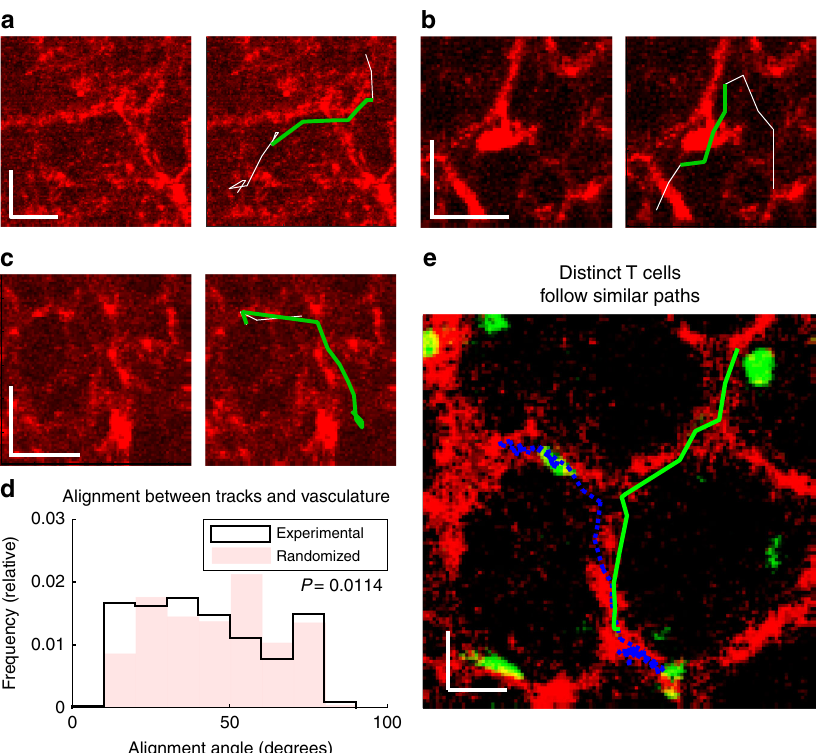
Fig. 5 Guidance of lung-in fi ltrating T cells along the vasculature. GFP + effector T cells were injected i.v. into LPS-treated mice. After two to fi ve days, the vasculature was labeled intravitally by intravenous injection of fl uorescently labeled lectin. Two-photon imaging of explanted lungs enabled simultaneous visualization of GFP + T cells and the vasculature. a – c High-resolution images of vascular stain of live lung tissue ( left panels ) with superimposed T cell trajectories ( right panels ). Tracks that are apparently aligned with the vasculature are highlighted in green. Scale bars = 20 µ m. d Tracks were split into 24 µ m wide segments ( n = 414 segments from ten movies). For each experimental segment, a randomized control segment was generated. An alignment angle, between segments and the main orientation of the vasculature, was calculated for all experimental and randomized segments. The Mann – Whitney test was used to calculated P -values for comparison of alignment angles from experimental and randomized segments. e High-resolution image of lung region displaying adoptively transferred T cells (in green ) and lung vasculature (in red ). The blue dotted line and the green solid line indicate tracks of two distinct T cells. Scale bar = 20 µ